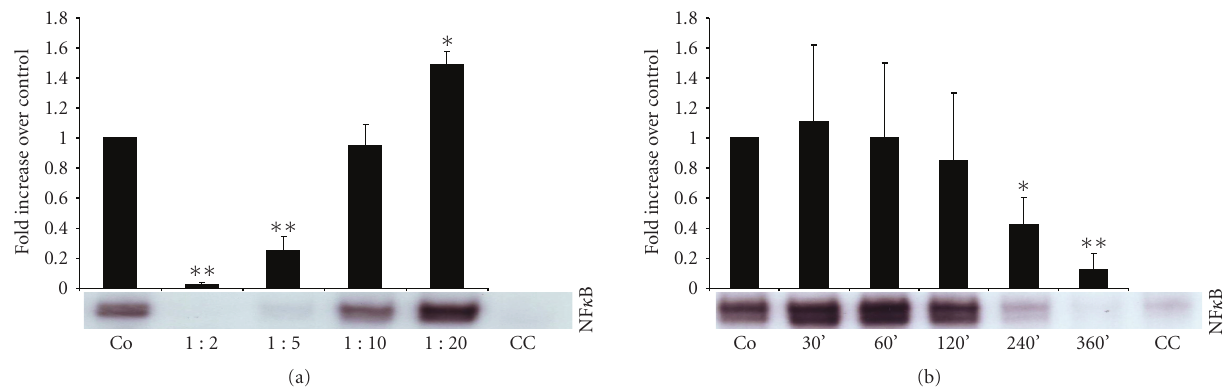
Figure 3: Gel-shift analysis of the transcripton factor NF κ B. Treatment with Rhizoma coptidis inhibited binding activity in a dose-dependent (incubation time 240 min), (a) and time-dependent (dilution 1 : 5), (b) fashion. NF κ B: nuclear factor κ B, Co: LPS-stimulated control cells, and CC: cold competition. ∗ P < . 005, ∗∗ P < . 001.